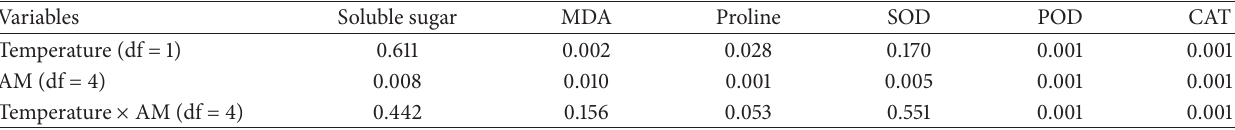
Table 2: Output of two-way ANOVA ( 𝑃 value) on the effects of temperature and AMF on physiobiochemical parameters of maize seedlings.